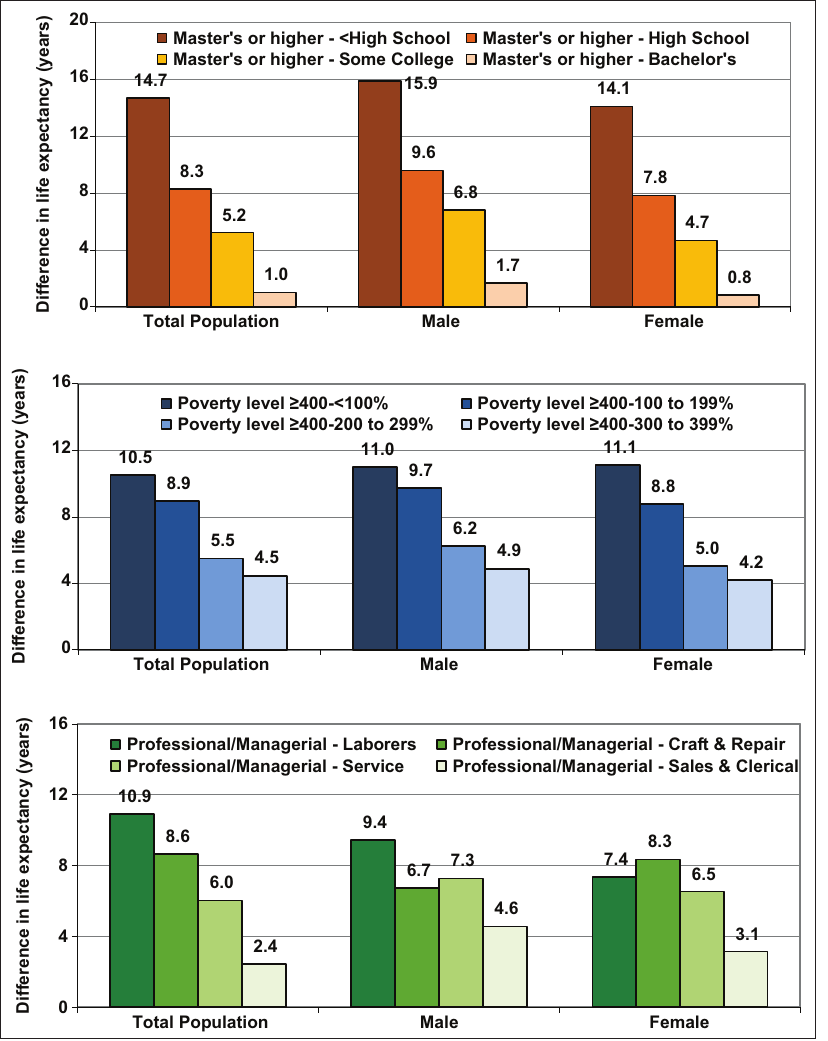
Figure 1: Differences in Life Expectancy at Age 18 Across Education, Poverty, and Occupation Groups, United States, 1997-2014 Gradients in life expectancy by education, poverty level, and occupation were statistically significant at p<0.001. All life expectancy differences between the highest socioeconomic category and other categories were statistically significant at p<0.01, except for the difference between Master’s degree or higher and bachelor’s degree for women